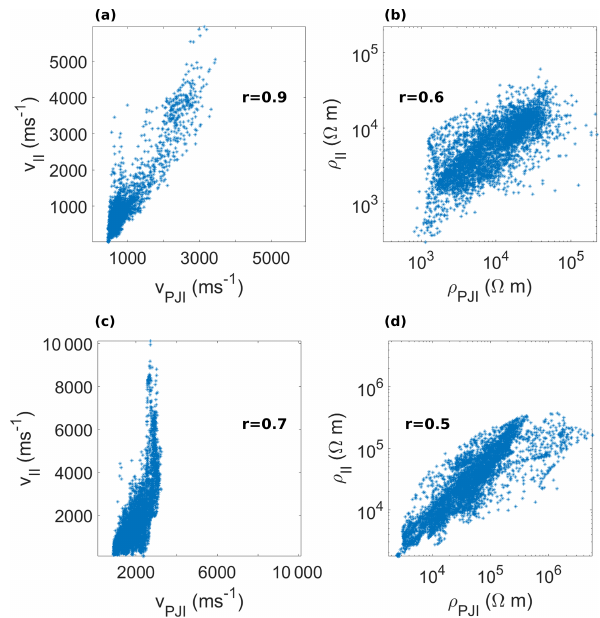
Figure 8. Correlation of P-wave velocity and resistivity model re- sults between individual dataset inversion (II) and petrophysical joint inversion (PJI). El Jote P-wave (a) velocity and (b) resistiv- ity model values. El Ternero P-wave (c) velocity and (d) resistivity model values. In each figure the correlation coefficient r is indi-